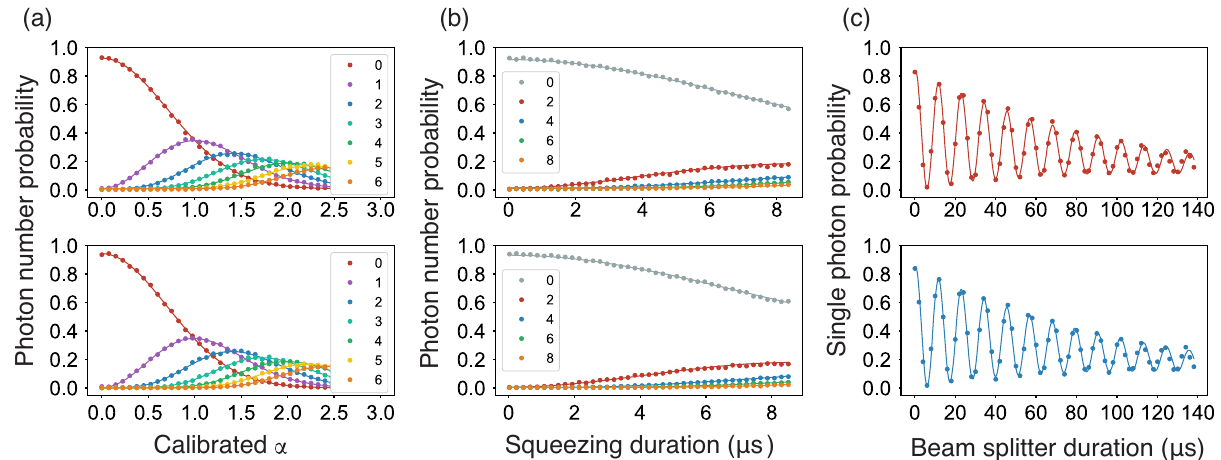
FIG. 4. Calibrations for Gaussian operations. (a) Displacement calibrations for cavities A (top) and B (bottom) starting in vacuum. Here, the amplitude of a resonant pulse is varied. (b) Squeezing calibration for cavities A (top) and B (bottom) starting in vacuum. Here, the length of two squeezing pump tones is varied. Legends indicate population in photon number n . (c) Beam splitter calibration for beginning with a single photon in cavities A (top, j ψ 0 i ¼ j 1 ; 0 i ) and B (bottom, j ψ 0 i ¼ j 0 ; 1 i ). The length of two beam splitter pump tones is varied, and the probability that the photon remains in the cavity that it started in is plotted over time.